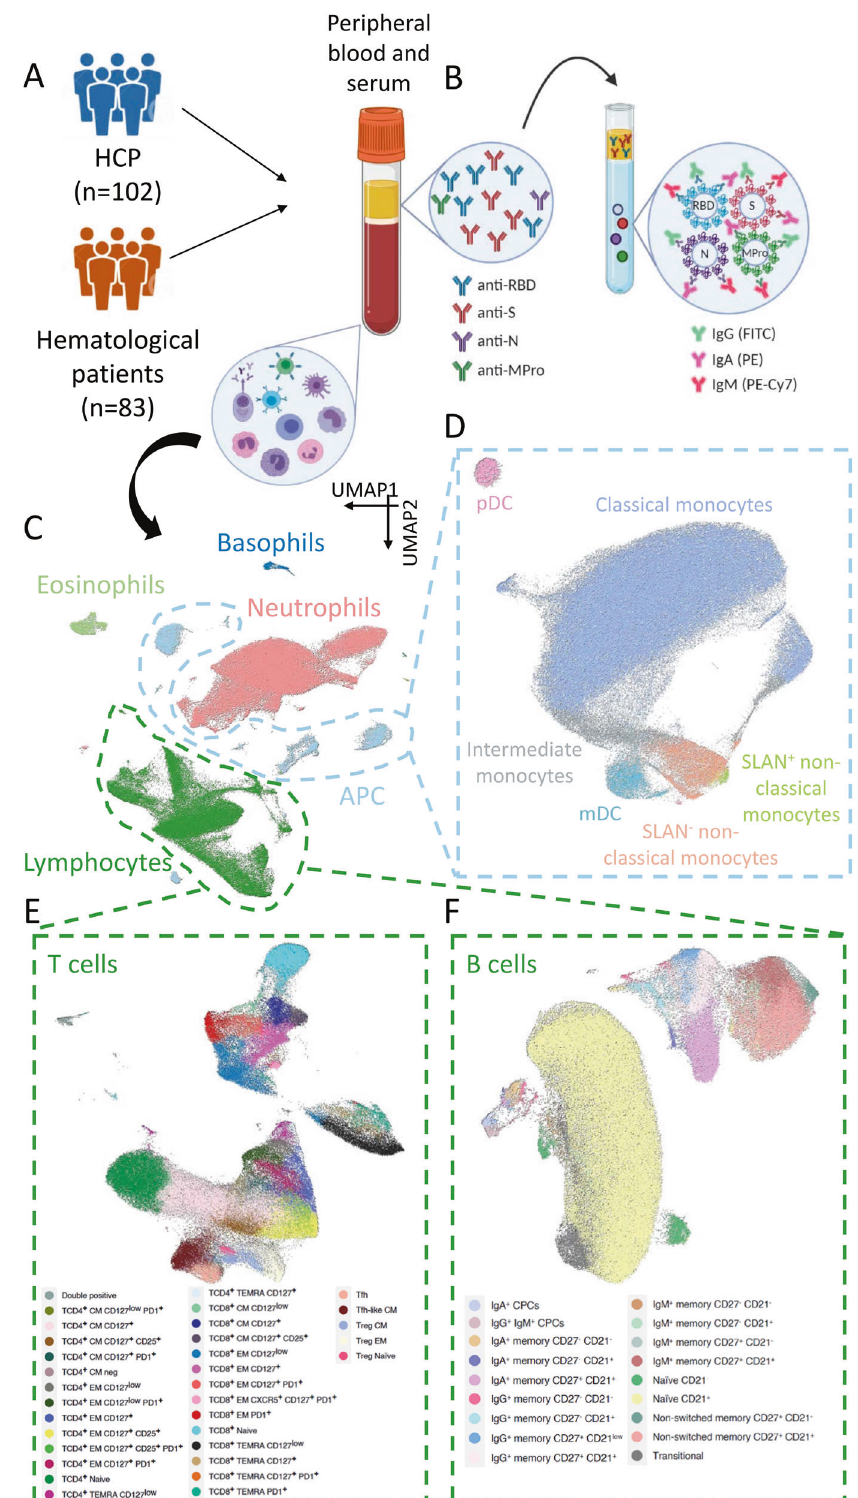
(Table 2). There were seven cases diagnosed with CLL, 25 with indolent and 16 with aggressive non-Hodgkin lymphoma subtypes and 28 patients had a monoclonal